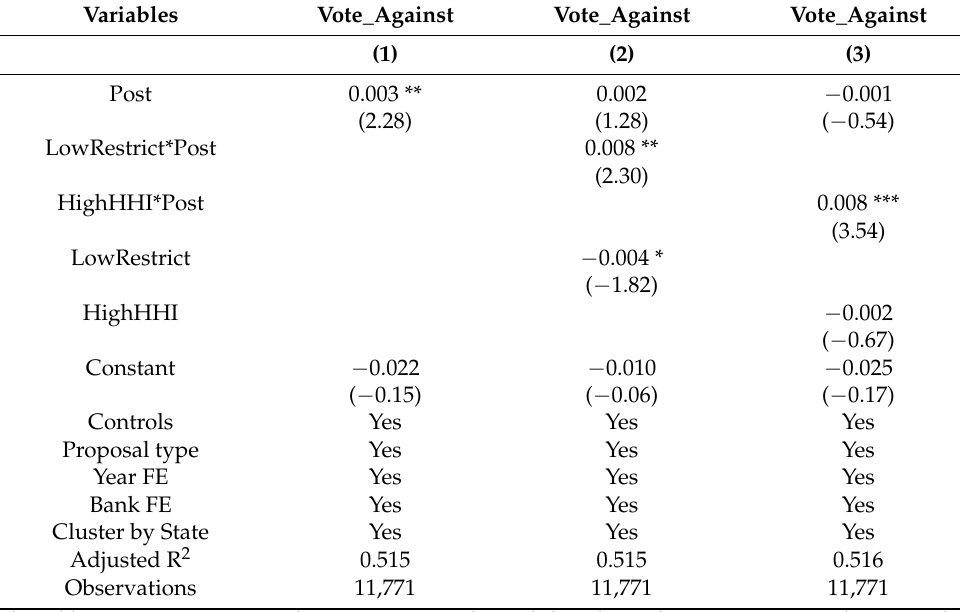
Table 7. Sample with a 3-year event